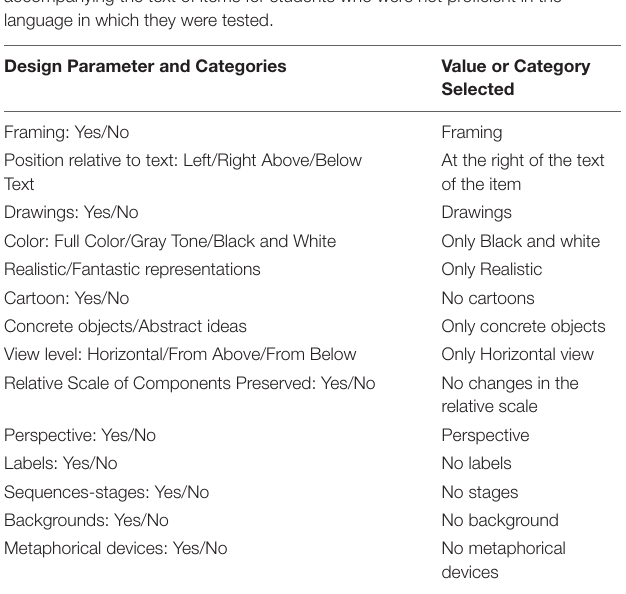
TABLE 4 | Design parameters of illustrations used to create illustrations accompanying the text of items for students who were not proficient in the language in which they were